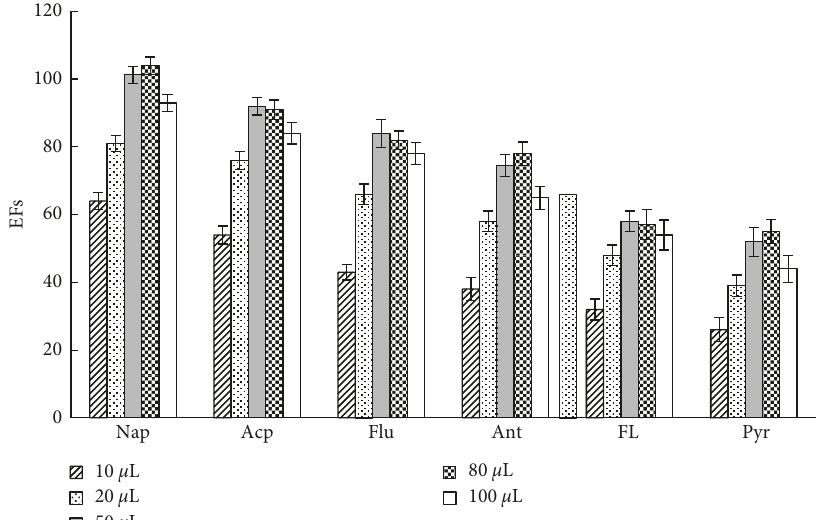
Figure 3: The effect of IL volume on EFs. Other extraction conditions: 10mL of aqueous standards (containing PAHs at a concentration of 5 μ g · L − 1 ); extraction temperature, 50 ° C; extraction time, 30min; the concentration of NaCl, 25%. Values are mean of n � 3 replicates.